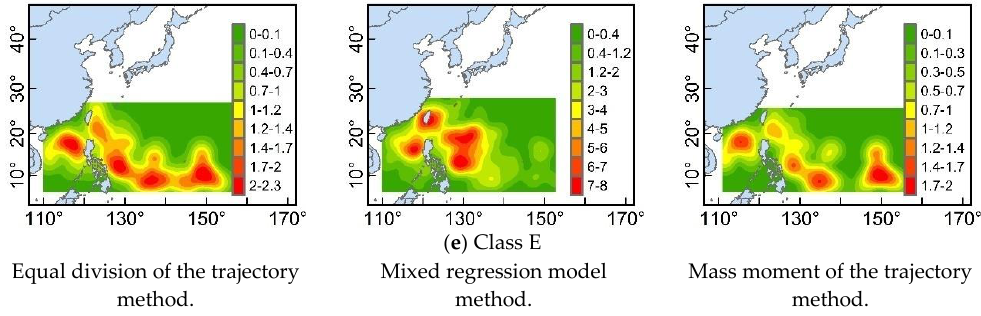
Figure 4. ( a – e ) kernel density distribution of genesis locations for the TC trajectories in the different classes according to the different trajectory clustering methods. The density is the number of TC genesis points per square kilometre, and the unit is 10 −5 events /km 2 . Table 3. Average longitude and latitude coordinates of the starting TC trajectory points in different classes.